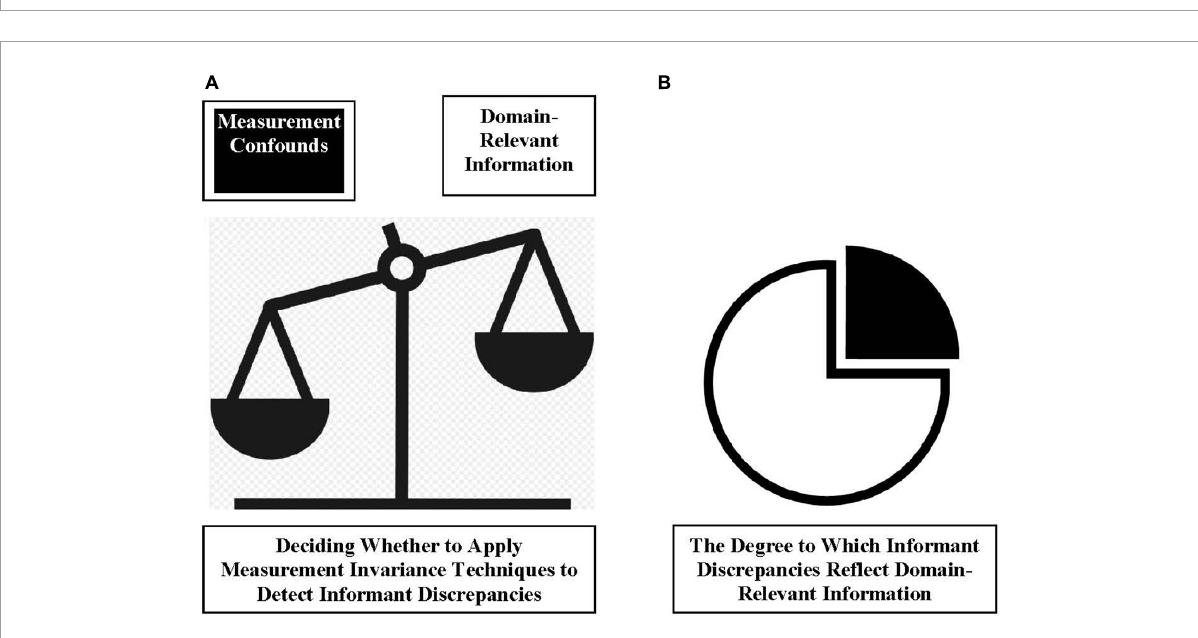
FIGURE2 Graphical depiction of the discrete nature of decisions regarding the use of measurement invariance techniques to detect informant discrepancies in youth mental health research. Given the existence of competing theories about what informant discrepancies reflect (see Figure 1 ), one requires a “referee” to decide when to apply measurement invariance techniques. The only reasonable means by which to resolve the issue of competing theories is to put the theories “to the test” using empirical data produced by well-constructed validation studies. As (A) depicts, the definition offered by Millsap (2011) logically results in one deciding to use measurement invariance techniques only when empirical data (i.e., results from well-constructed validation studies) clearly tilt in favor of inferring that the measurement conditions one seeks to